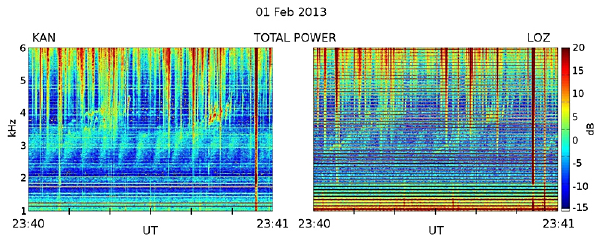
Figure 4. An example of periodic emissions (PE) that occurred only at KAN at 23:40–23:41UT on 1 February